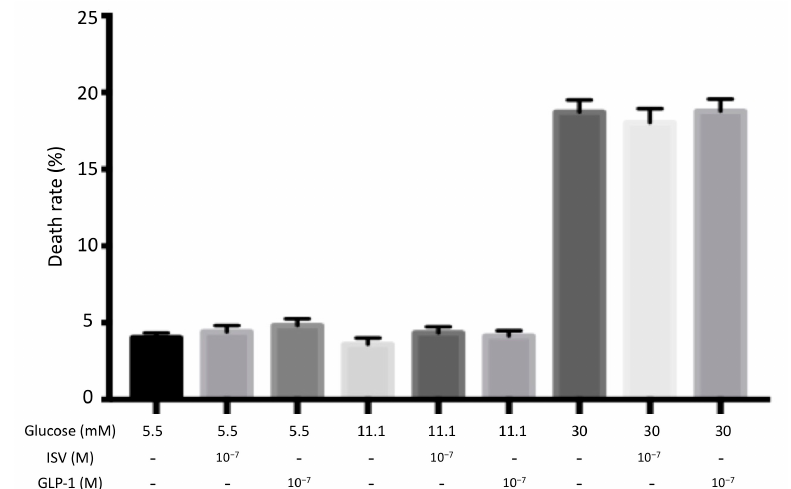
Figure 2. Effects 10 − 7 M ISV and 10 − 7 M Glucagon-like peptide-1 (GLP-1) on cell death rate in glucose-treated INS-1E cells. We measured cell death rate following 72 h of incubation with or without 10 − 7 M ISV/10 − 7 M GLP-1, in the presence of 5.5 mM, 11.1 mM, or 30 mM glucose. Data are presented as the mean ± SEM of 28 samples per group from three independent experiments.